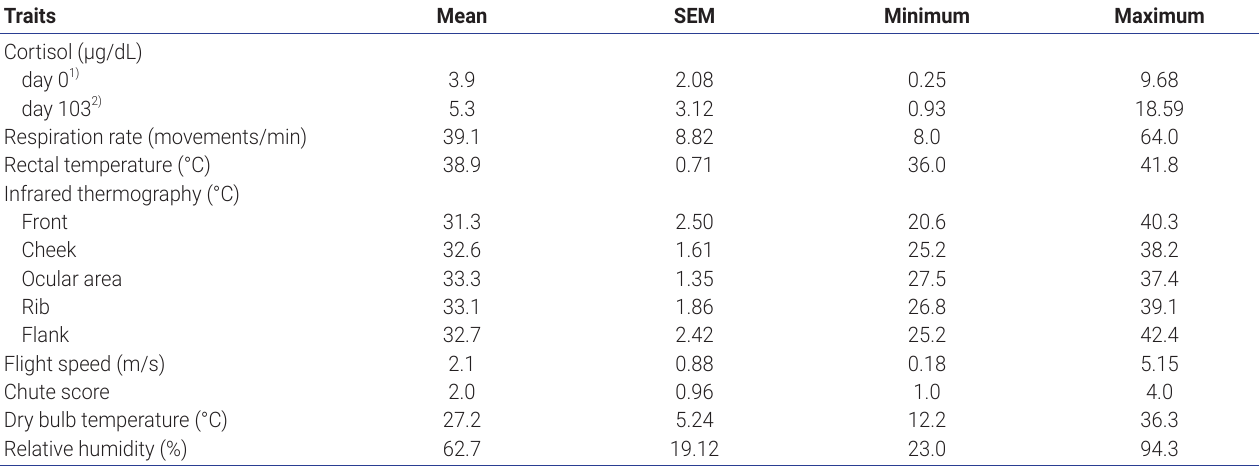
Table 2. Descriptive statistics of traits evaluated and environmental conditions Traits